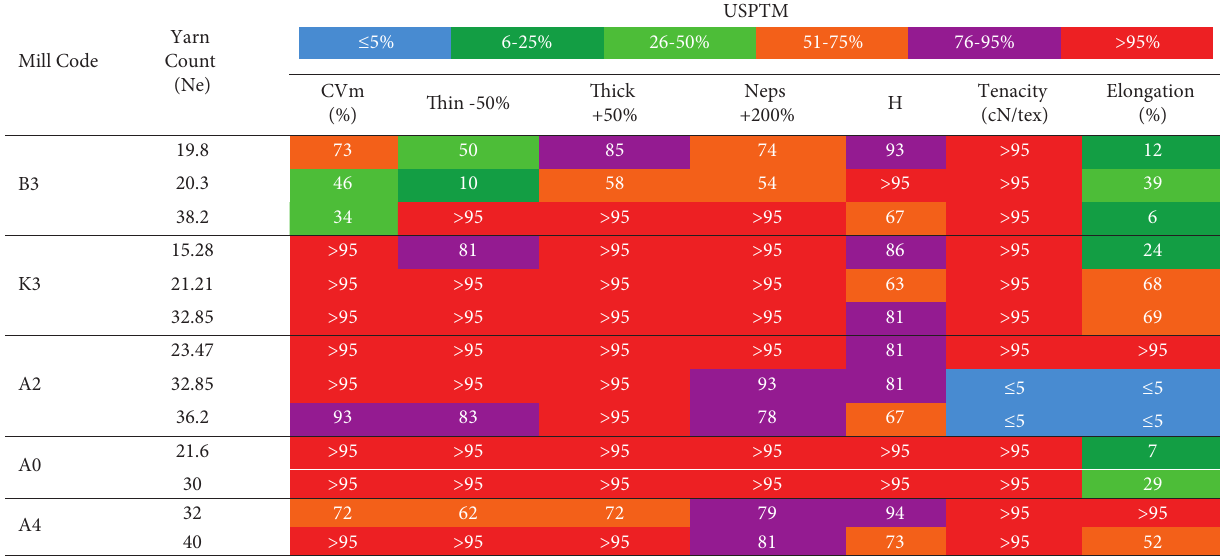
Table 8: USP Analysis of cotton yarns for weaving